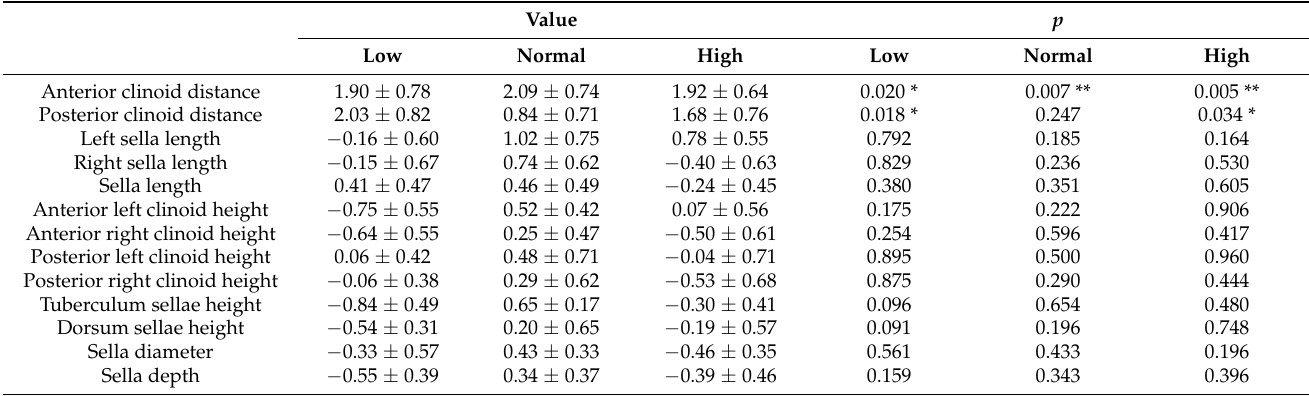
Table 8. Mean differences and significant levels between genders within three